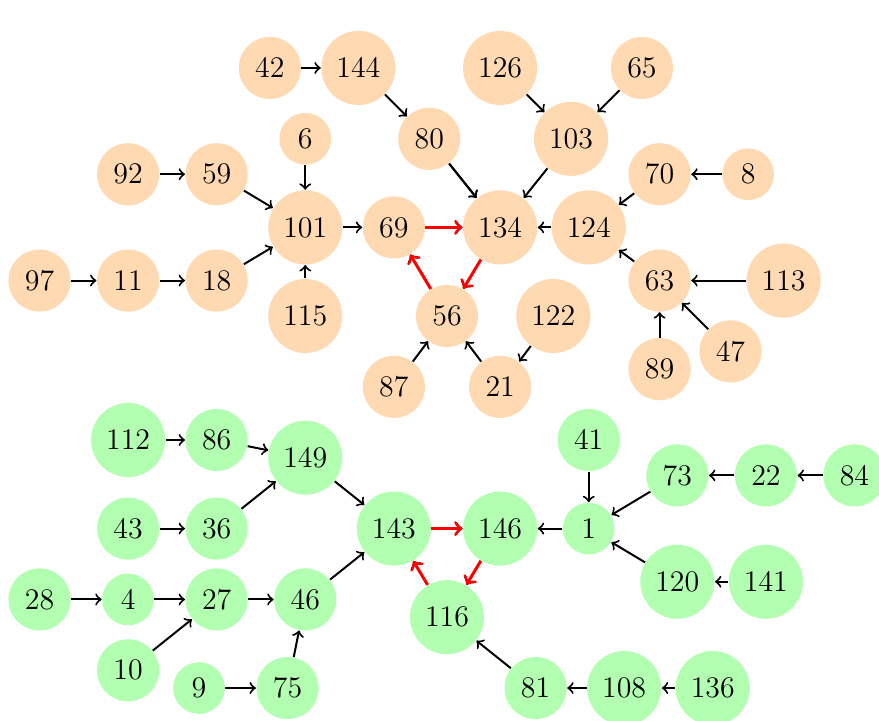
Figure 4: 2 components containing cycles of length